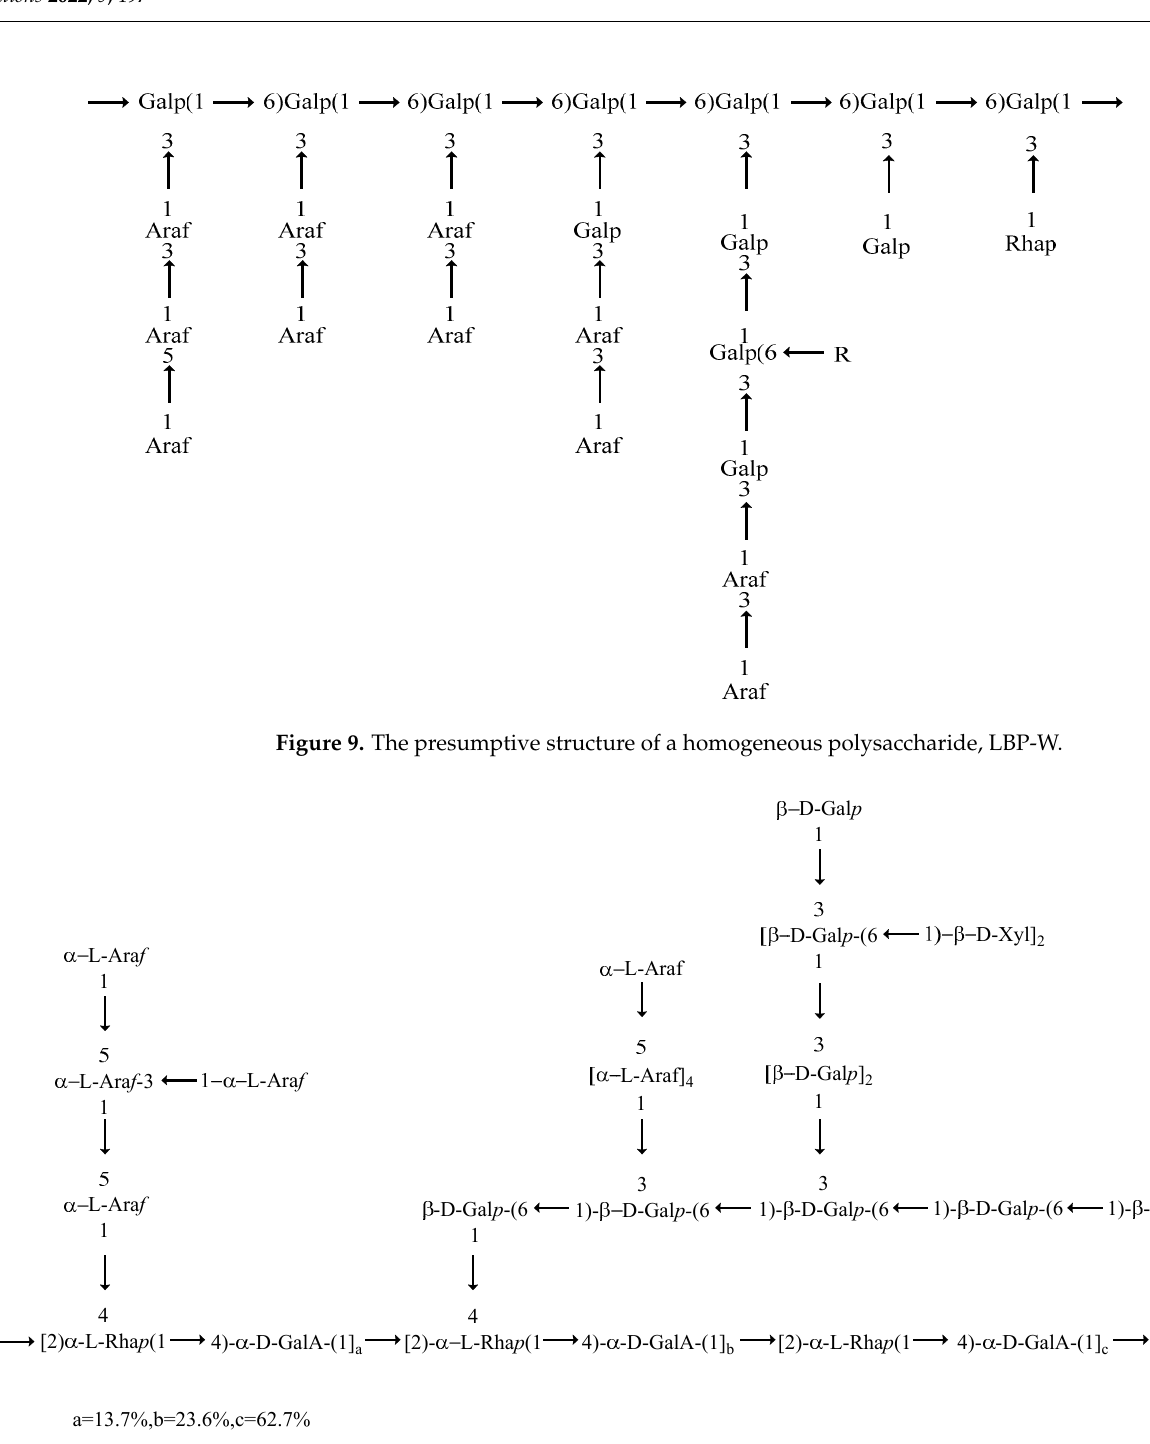
Figure 10. Putative structure of LRP3-S1.